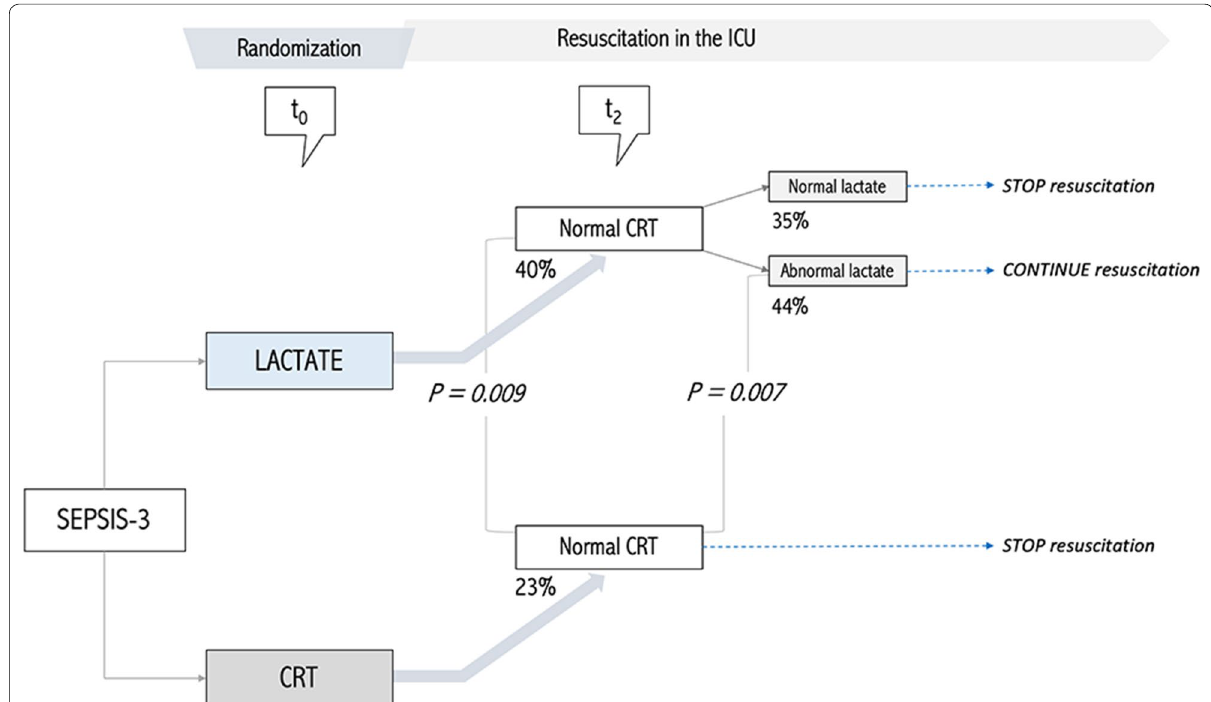
Fig. 2 Patients distribution at 0 and 2 h after ICU admission and associated outcome according to randomization group, under CRT state perspective. Percentages refer to 28‑day mortality. All patients started with hyperlactatemia. Lactate arm pursued lactate normalization or significant lowering, irrespective of CRT state. CRT arm pursued CRT normalization